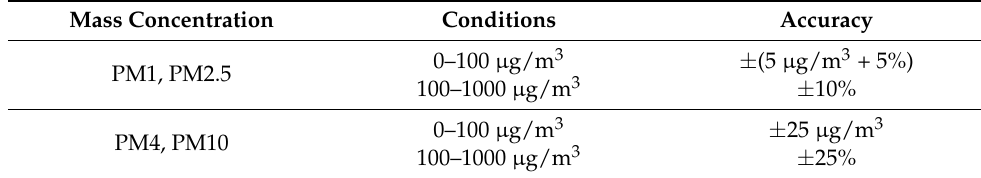
Table 2. Accuracy of SEN54